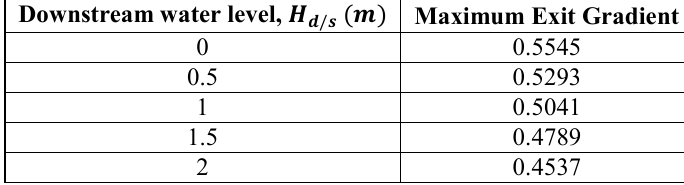
Effect of Downstream water level on Maximum Exit Gradient.